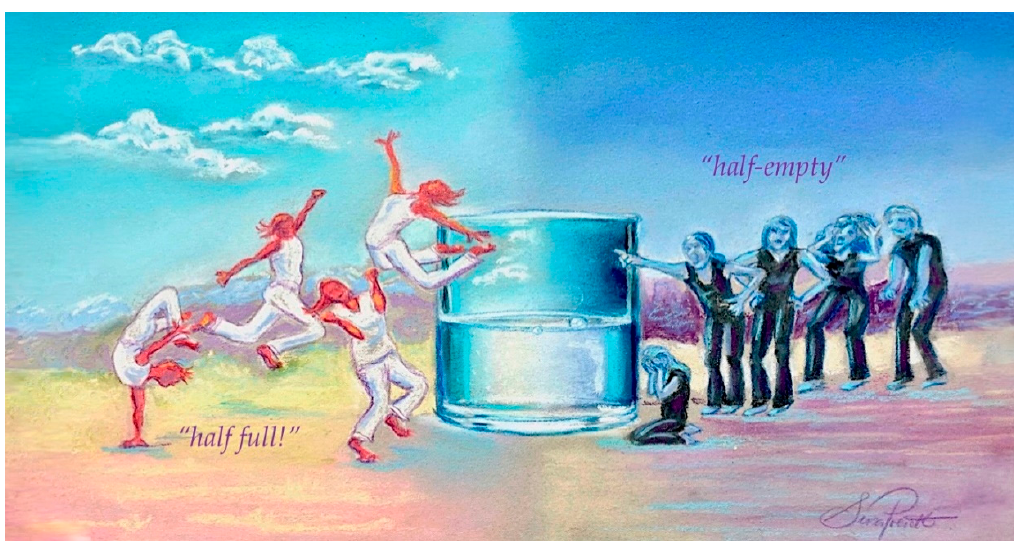
Figure 2. Narratives that prime attitudes and expectations have tangible health effects (on stress, inflammation, and aging). Decades of research showing subjective, physiological, and functional effects of placebo.